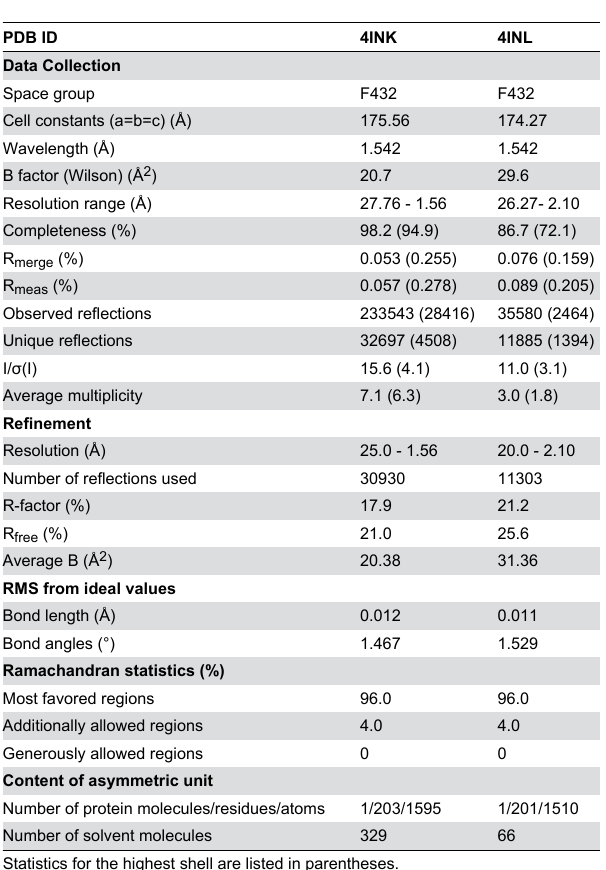
Table 1. Experimentally determined SplD cleavage sites within proteins and peptides.